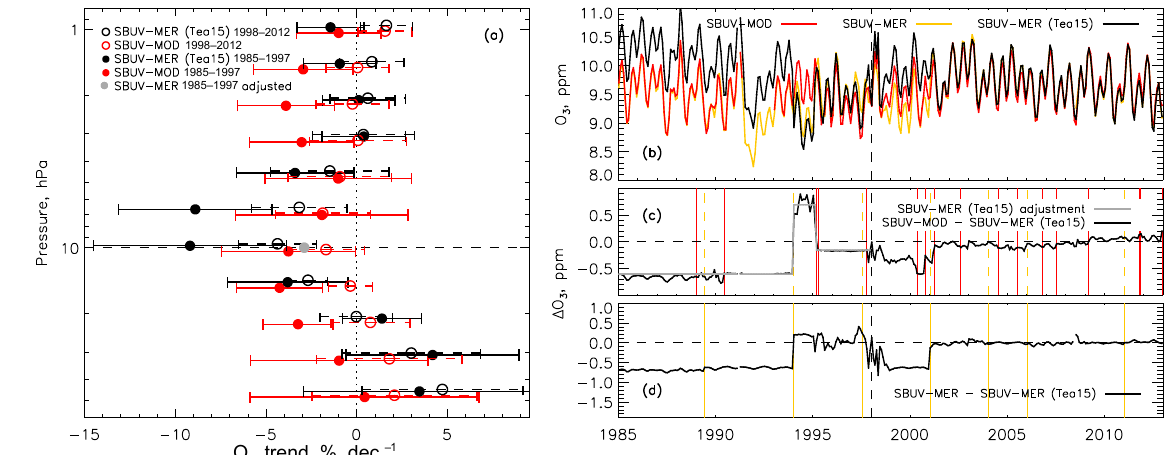
Figure 2. (a) The equatorial (20 ◦ S–20 ◦ N) decadal ozone MLR trend profiles for the SBUV-MER version used by Tummon et al. (2015) (“Tea15”; black) and SBUV-MOD (red). Dots and solid error bars represent the 1985–1997 trends, and open circles and dashed error bars the 1998–2012 period. A single grey dot is plotted at 10hPa, which follows an adjustment to SBUV-MER as shown in panel (c) as a grey line. (b) The ozone composite time series for SBUV-MER (Tea15) (black), SBUV-MER (yellow) and SBUV-MOD (red) at 10hPa, all shifted to the July 2005–2012 mean of SWOOSH. (c) The difference between the SBUV-MOD and MER (Tea15) time series in panel (b) ; the grey line prior to 1998 is a correction applied to SBUV-MER (Tea15) to produce the grey dot in panel (a) . (d) The difference between SBUV-MER (Tea15) and SBUV-MER. The vertical dashed line in panels (b–d) indicates 1 January 1998, which delimits the two periods considered in the MLR results in panel (a) . Error bars are 2 σ